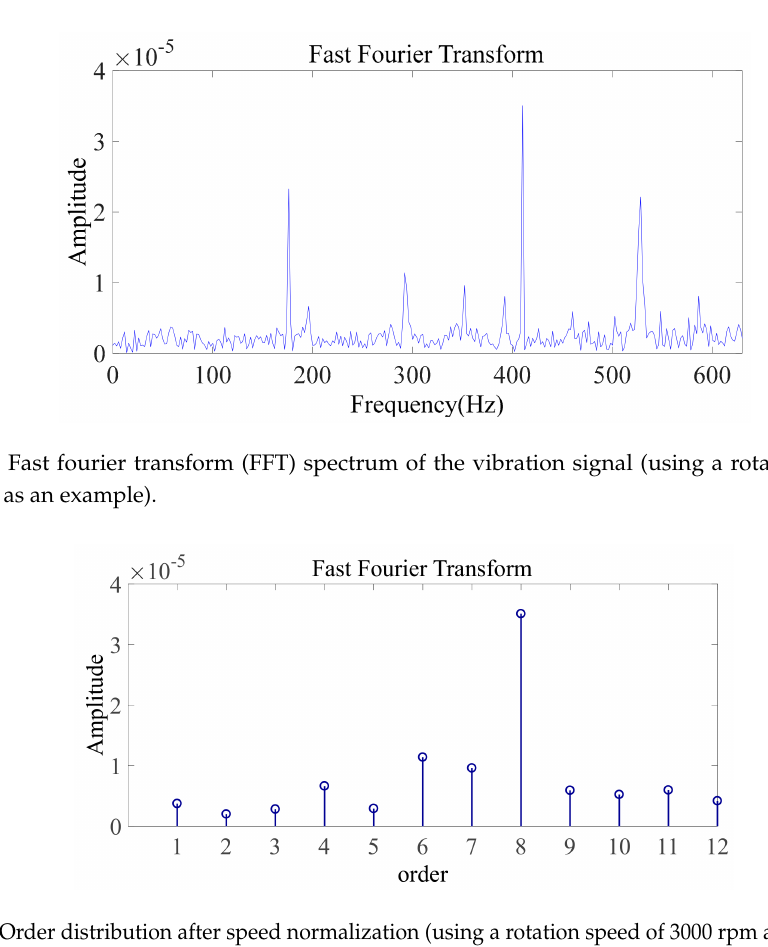
Figure 3. Signal processing and analysis procedures.